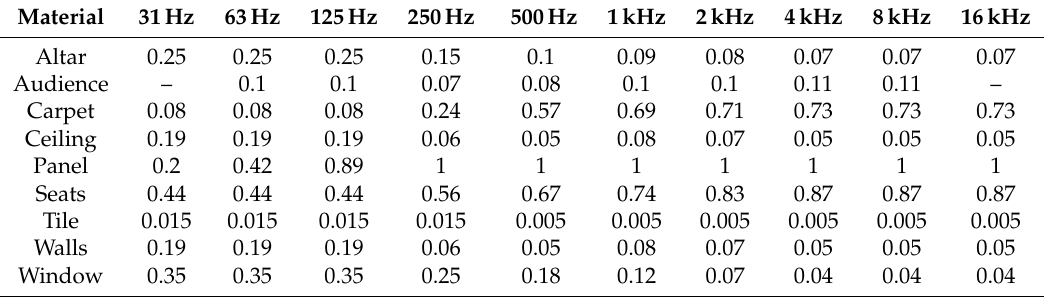
Figure 4. ( left ) CAD model for Odeon simulations (without panels); ( right ) CAD model for wave-based simulations (with panels). Axes units are in meters. Table 2. Absorption coefficients of materials used in GA and wave-based models. “Audience” material only used for Odeon, and “Seats” were used only in wave-based. Odeon only takes into account 63–8000 Hz data, whereas wave-based simulations took into account all octave band data